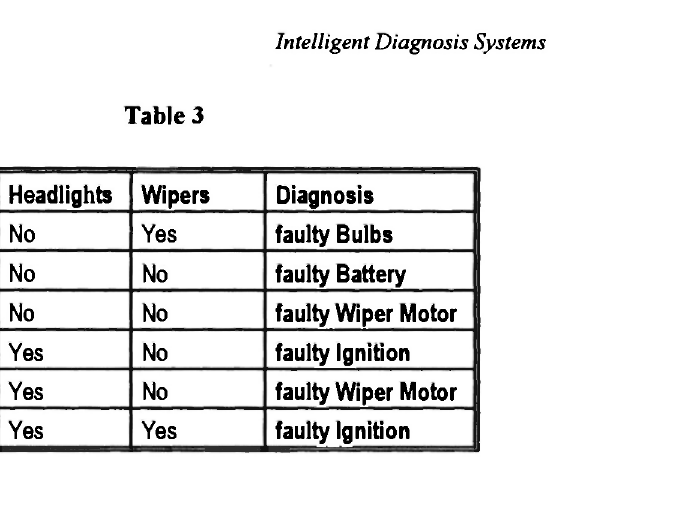
Engine Headlights